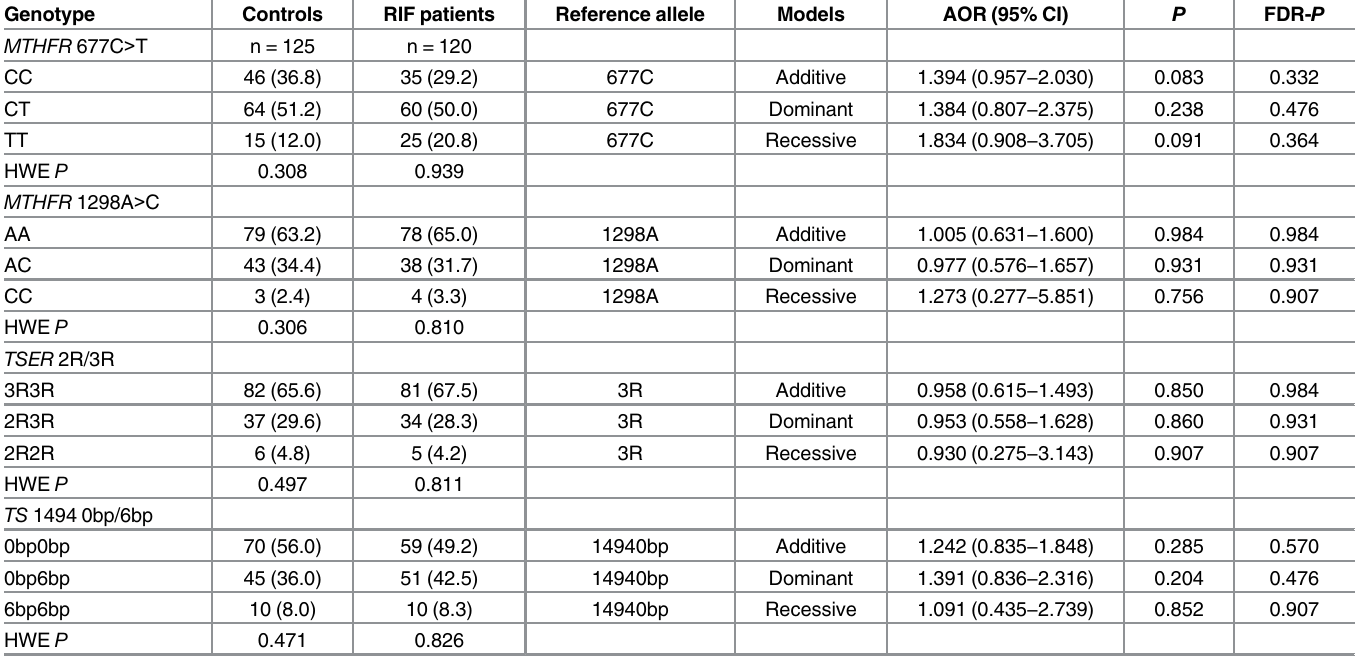
Table 2. Genotype frequencies of one-carbon metabolism-related gene polymorphisms between controls and RIF patients.